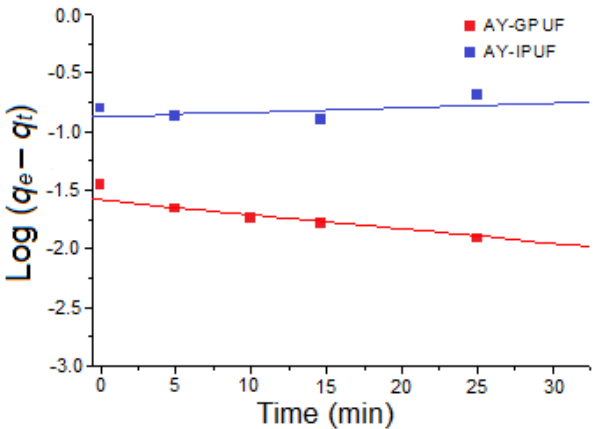
FIGURE 11 - Lagragren plot for adsorption of CAF onto AY- GPUF and